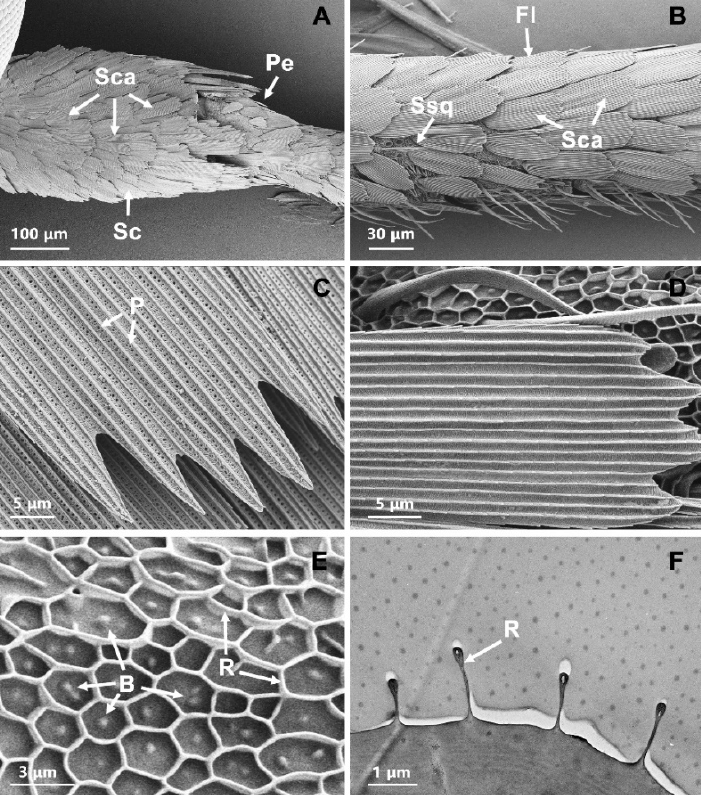
Figure 2. Scanning electron micrographs and transmission electron micrographs of scales and the reticular surface. ( A ) Distribution characters of scales on scape and pedicel segments; ( B ) distribution characters of scales on flagellar segments; ( C ) the structure characters of scales on scape and pedicel segments; ( D ) the structure characters of scales on flagellar segments; ( E ) the reticular network structure on the flagellar segment; ( F ) longitudinal section of ridges extended over the antennal surface. Sc: scape; Pe: pedicel; Fl: flagellum; Sca: scale; P: pore; R: